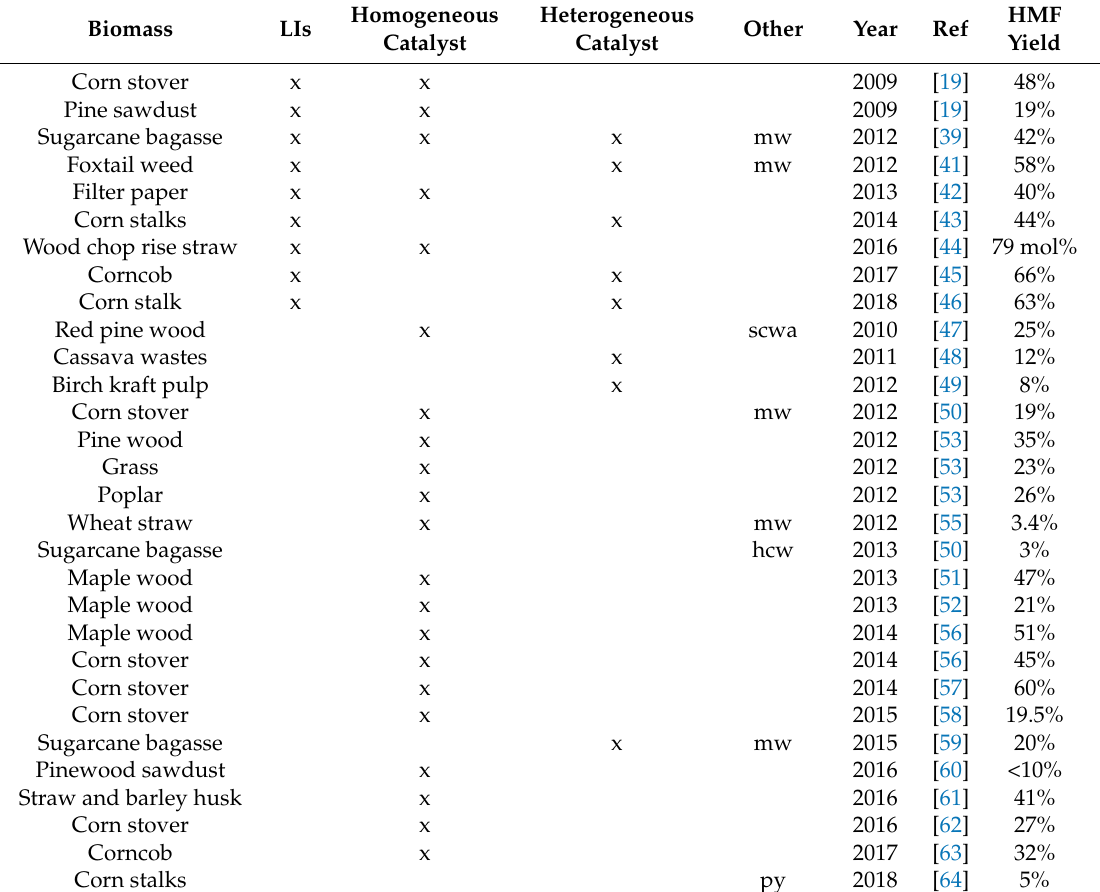
Table 2. HMF production from non-edible lignocellulosic